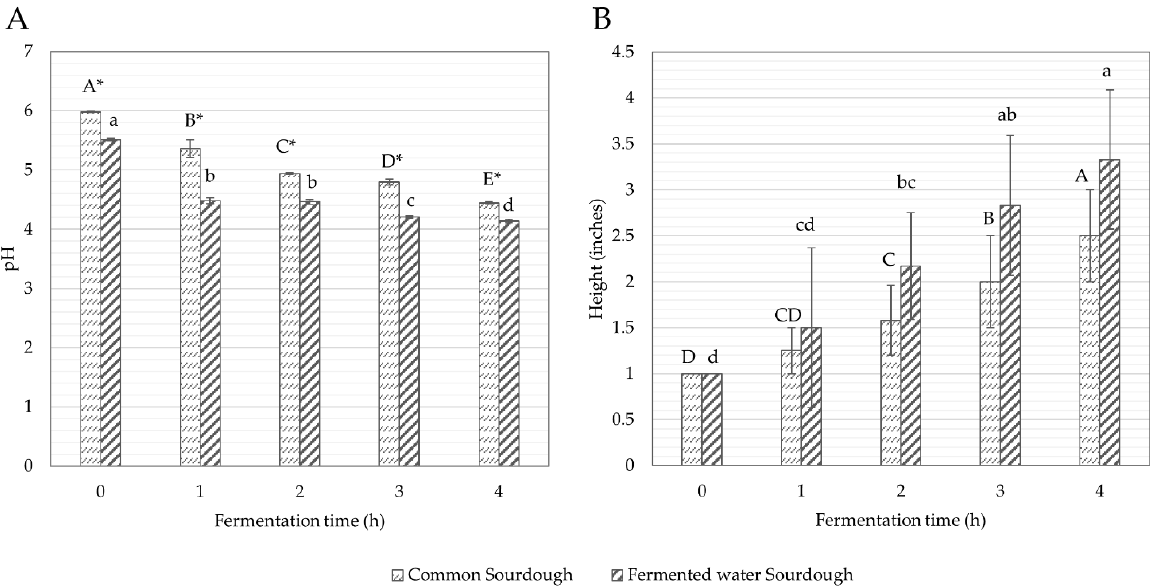
Figure 2. A trend in ( A ) pH and ( B ) height of common sourdough and fermented water sourdough over fermentation time periods. Results were expressed as mean values of triplicate determinations ( n = 3). Different uppercase and lowercase letters denote significantly different values (pH or height) at p < 0.05 in common sourdough and fermented water sourdough, respectively, fermented at different time periods using one-way ANOVA, followed by Duncan’s multiple comparison test, while * denotes significantly different values (pH or height) at p < 0.05 between common sourdough and fermented water sourdough fermented at the same time period using Student’s unpaired t -test.